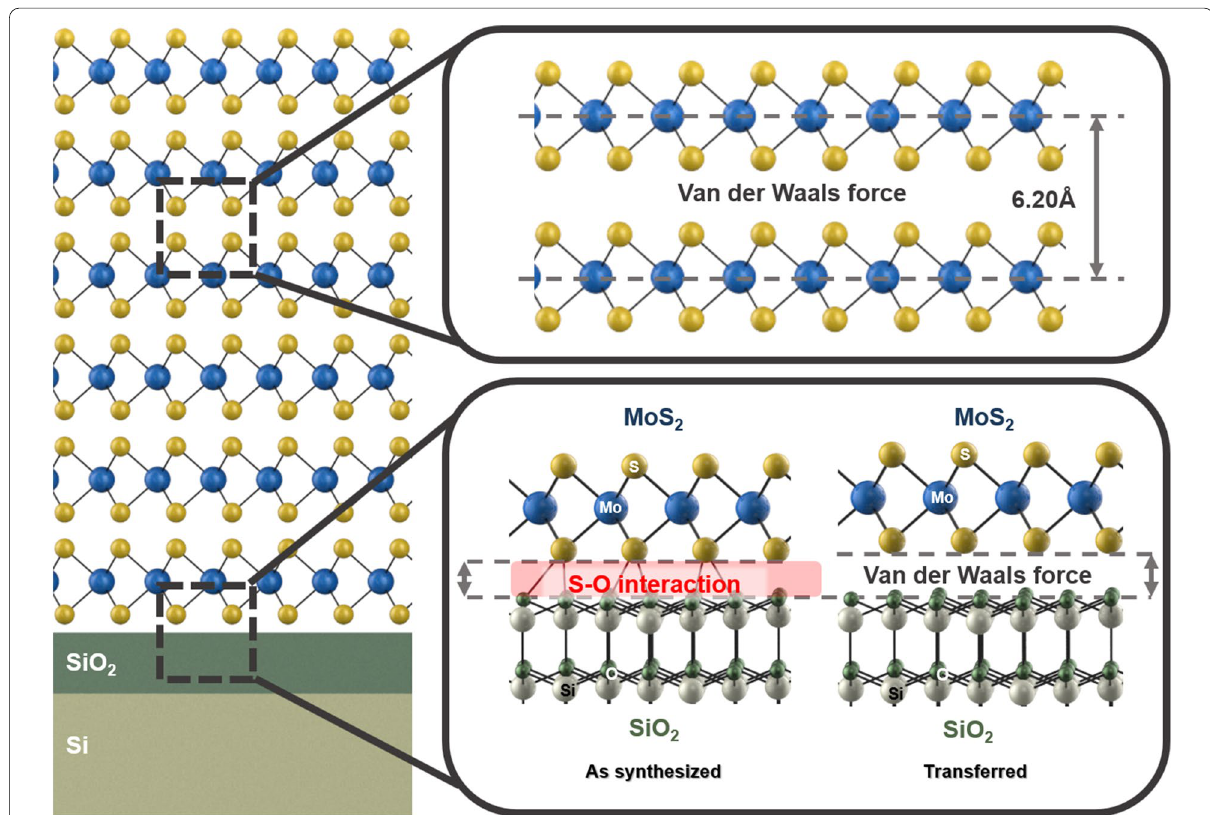
Fig. 6 Schematic illustration of the phenomena at the AS and TR-MoS 2 /SiO 2 interface. At the AS-MoS 2 /SiO 2 interface, the interlayer distance decreases due to the formation of S–O bonding, whereas there is no significant change in the interlayer distance at the TR-MoS 2 /SiO 2